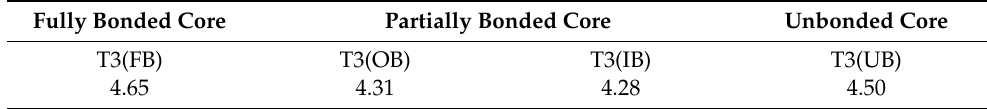
Table 4. Reliability indices for SPs with different core adhesion models.